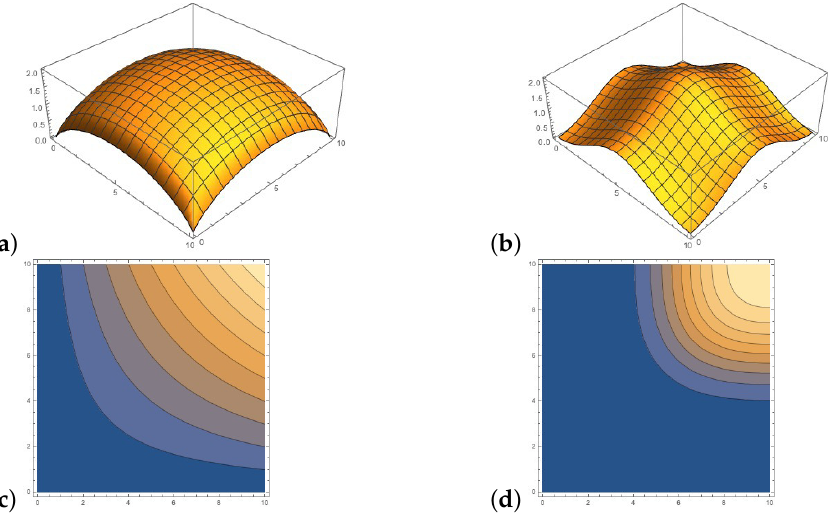
Figure 6. Different H 1 and H 2 values for sampled events x and y with Ω = 10: ( a ) H 1 ( x , y ) , ( b ) H 2 ( x , y ) , ( c ) counterplot of H 1 ( x , y ) , ( d ) counterplot of H 2 ( x , y )